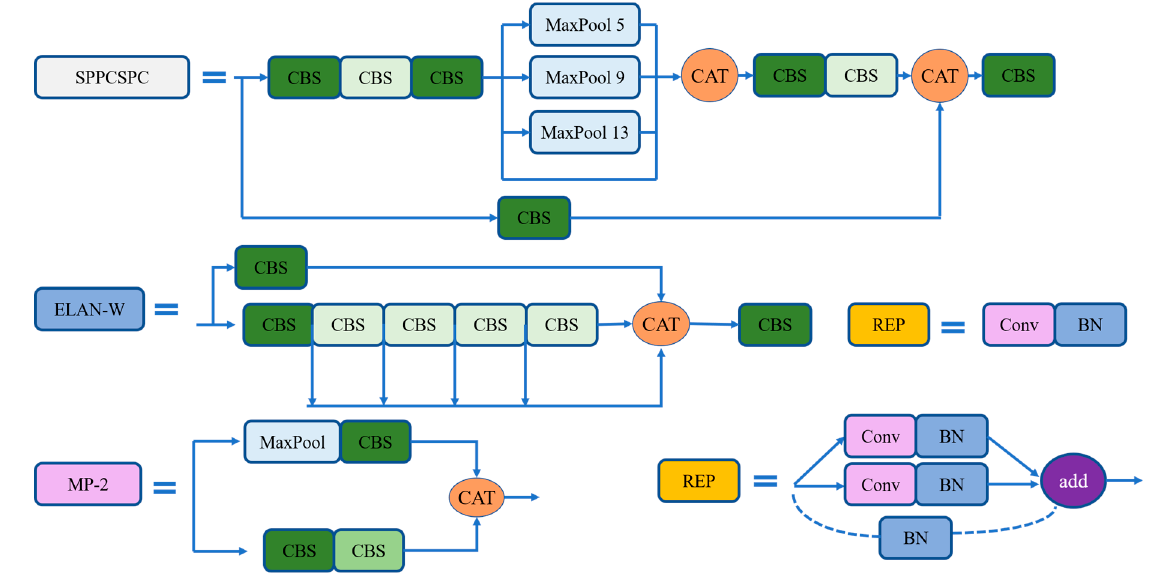
Figure 6. The SPPCSPC structure, ELAN-W structure, REP structure and MP-2 structure of head.